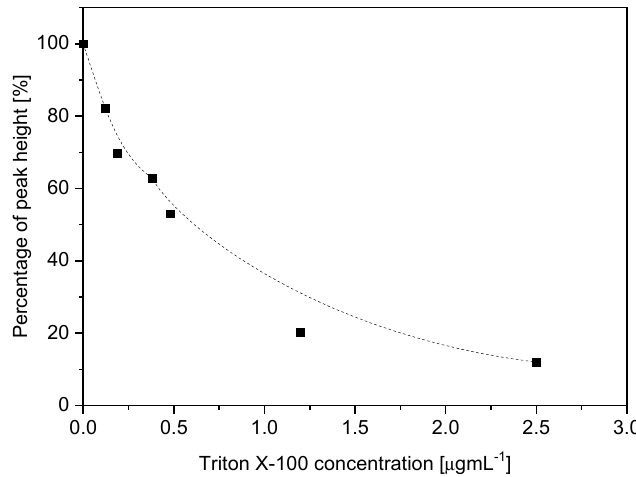
Figure 6. Influence of active-surface compound (Triton X–100) addition in range 0.5–2.5 mgL –1 on rifampicin peak height in 0.1 M CH 3 COOH. Instrumental parameters: ∆ E = 30 mV, Es = 4 mV, tw, tp = 10 ms. Stirring rate, 500 rpm.